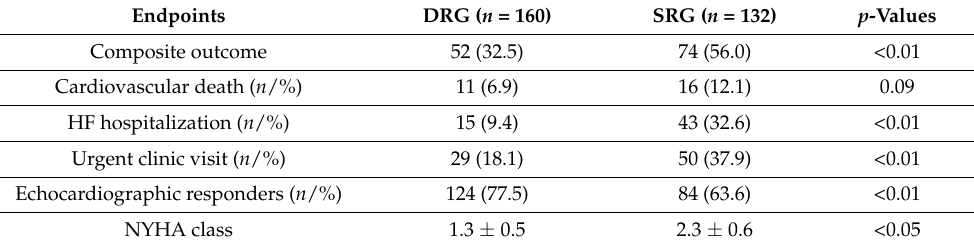
Table 3. Primary (composite outcome) and secondary (echocardiographic response and NYHA class) endpoints stratified for DRG and